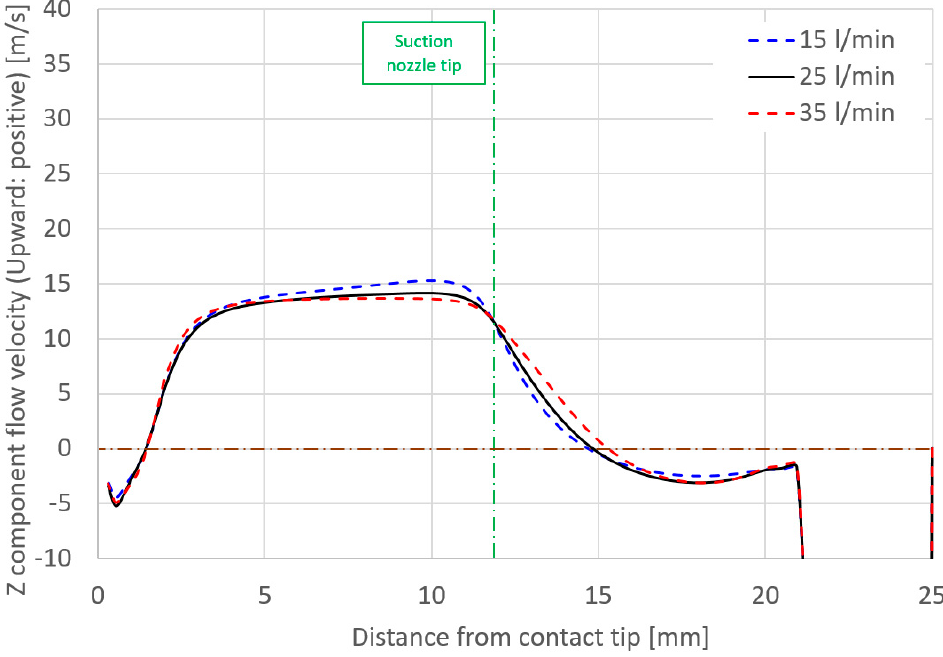
Figure 7. Axial distribution of Z component flow velocity as a function of the shielding gas flow rate.